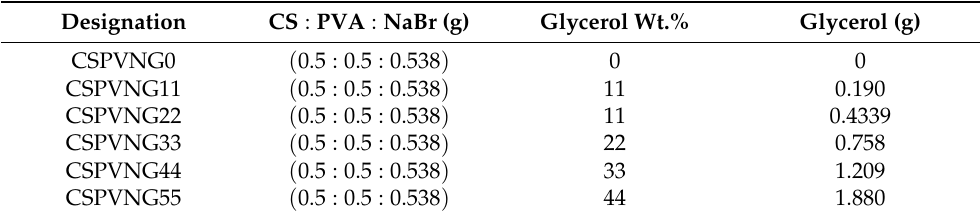
Table 5. Solid PE based on